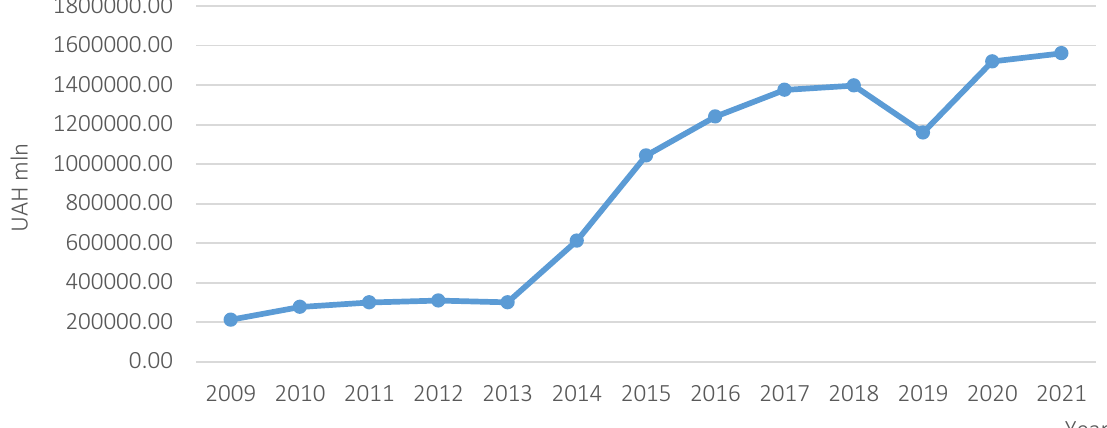
Figure 1. Time series chart of Ukraine’s external public debt for 2009–2021, UAH